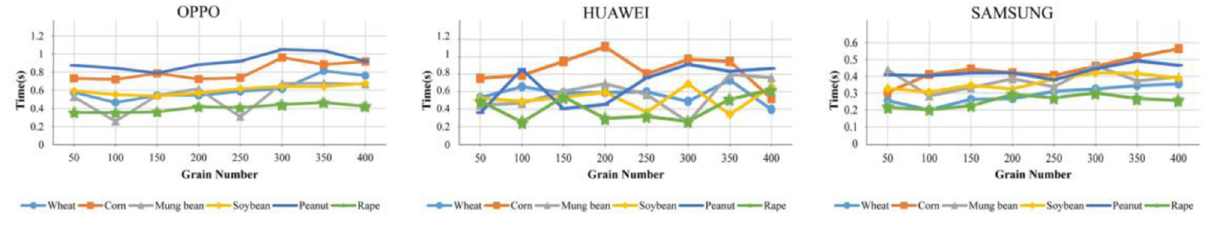
Fig 10. Time-consuming